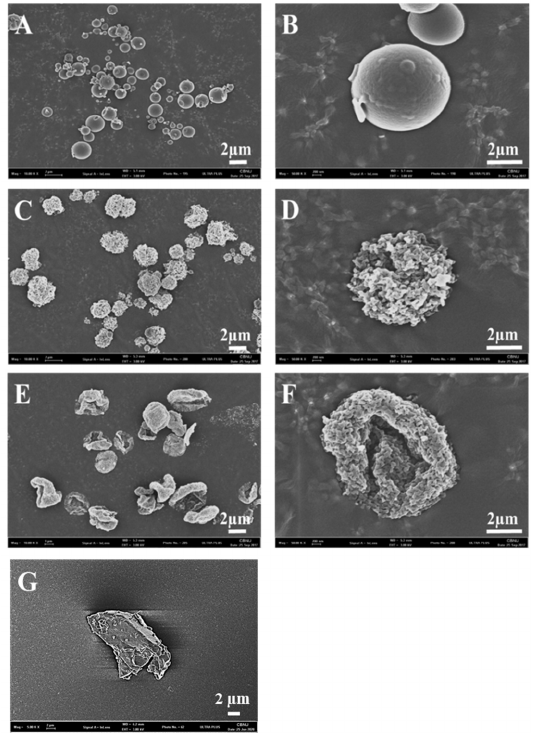
Figure 2. Scanning electron microscopy images of: ( A ) SD100; ( C ) SD80; ( E ) SD60; and ( G ) raw bosentan at magnification of 10 K; and ( B ) SD100; ( D ) SD80; and ( F ) SD60 at magnification of 50 K.